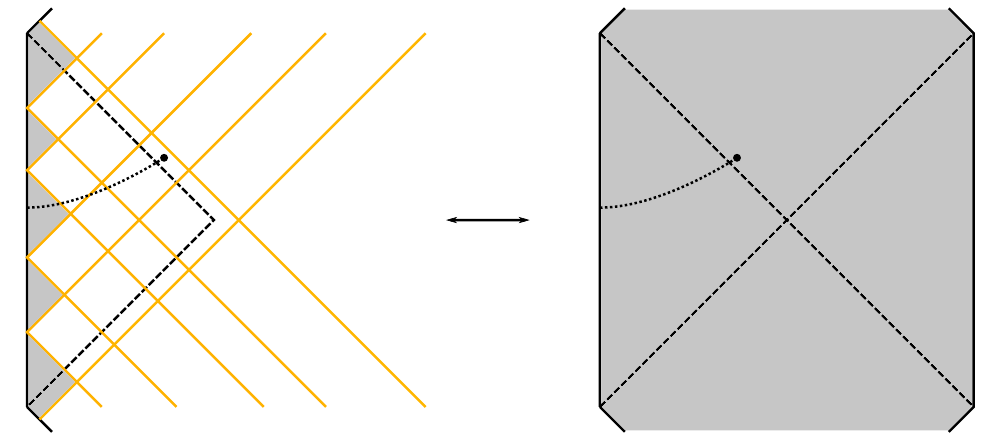
Figure 12 . For any shock wave solution, the dilaton in the shaded grey regions in the left diagram is identical to the dilaton in the vacuum solution shown on the right. This is sufficient to determine the location of the left future/past horizons in Kruskal coordinates, shown as dashed lines, so these are the same in both spacetimes. Moreover the dressing geodesic for the observable ψ only on the regularized boundary location in the grey regions and the metric, which are the same in both solutions, so it will end at the same point in Kruskal coordinates in both. We show such a dressing geodesic with the dotted